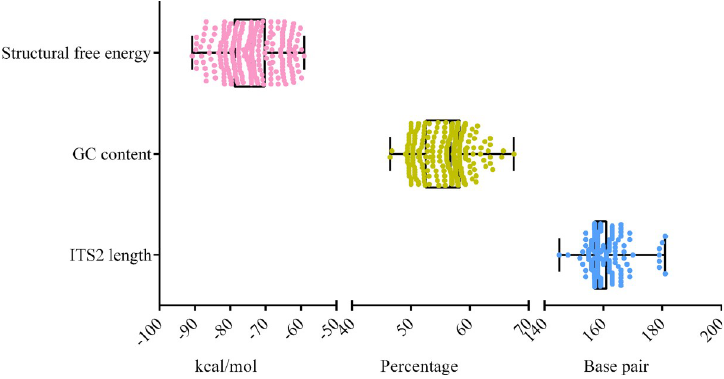
Fig 5. Box and whiskers plots depicting the secondary structral free energy, GC content and length of the ITS2 sequences employed in this study.